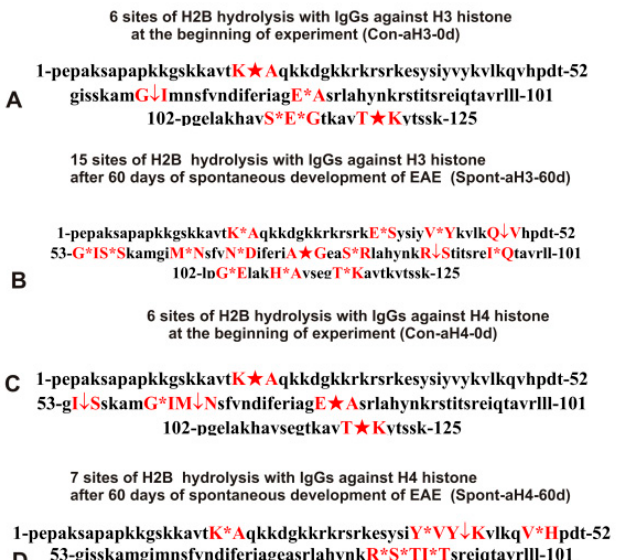
Figure 7. Sites of H2B hydrolysis by IgGs against three histones (H1, H2A, and H2B) corresponding to zero time (3-month-old mice) and after spontaneous development of EAE (before mouse im- munization) during 60 days: Con-aH1-0d ( A ), Spont-aH1-60d ( B ), Con-aH2A-0d ( C ), Spont-aH2A-60d ( D ), Con-aH2B-0d ( E ), and Spont-aH2B-60d ( F ). Major sites of H2B cleavage are shown by stars ( ★ ), moderate sites by arrows ( ↓ ), and minor sites of cleavage by small stars (*). Some data on the sites of H2B hydrolysis by IgGs against H3 and H4 histones are shown in Figure 8.